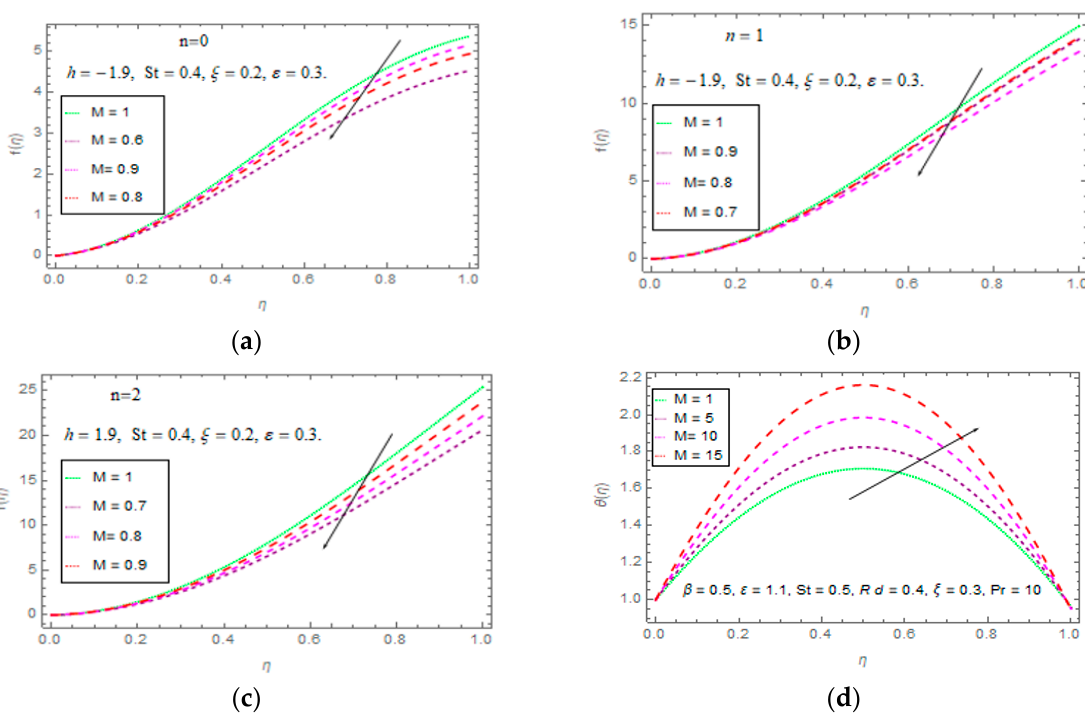
Figure 6. Effect of 𝑀 on 𝑓(𝜂) for 𝑛 = 0,1,2,3 .